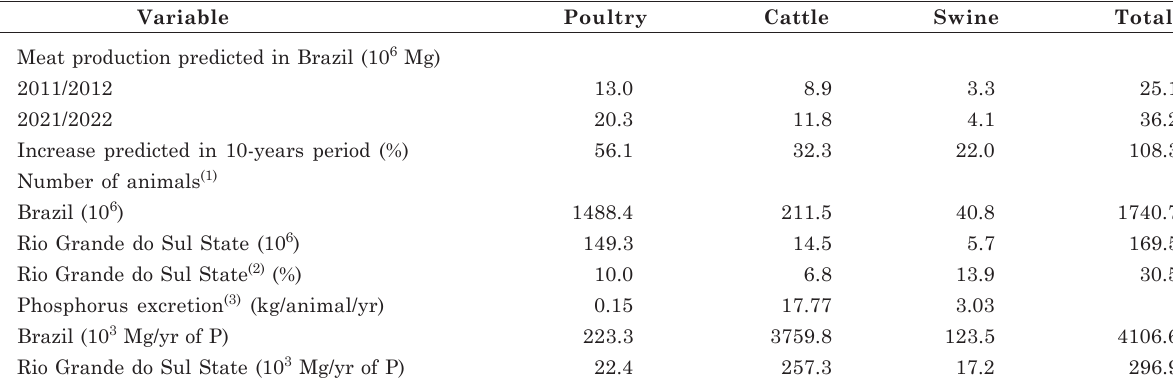
Table 1. The estimated increase from 2011/12 to 2021/22 in meat production; livestock and poultry population and phosphorus excretion in Brazil and Rio Grande do